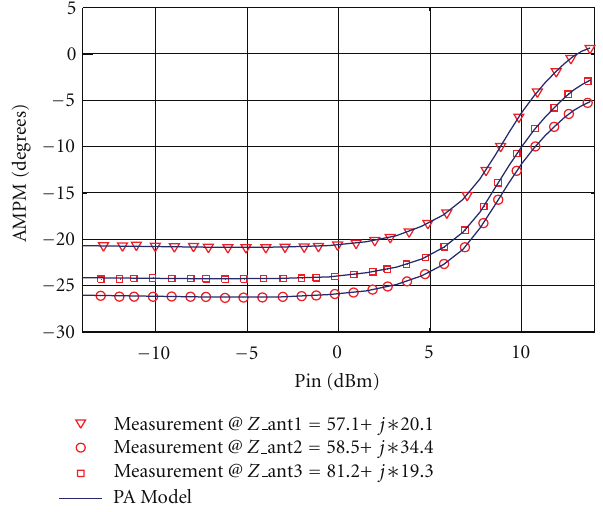
Figure 20: Phase modulation (AMPM) versus input power for three calculated impedances (Z ant1 = 57 . 1 + j ∗ 20 . 1, Z ant2 = 58 . 5 + j ∗ 34 . 4, and Z ant3 = 81 . 2 + j ∗ 19 . 3) using the EM analysis tool. PA model (lines) compared to load pull measurement (symbols). F 0 = 8 . 2 GHz.